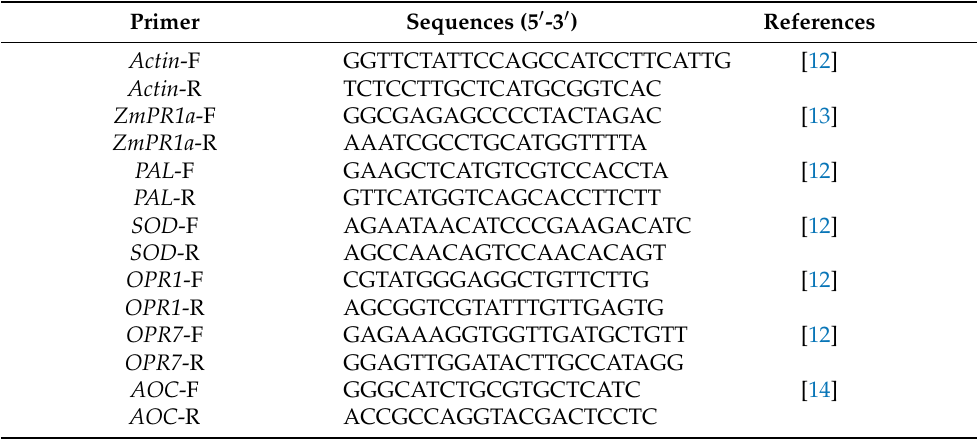
Table 2. Sequences of primers used in